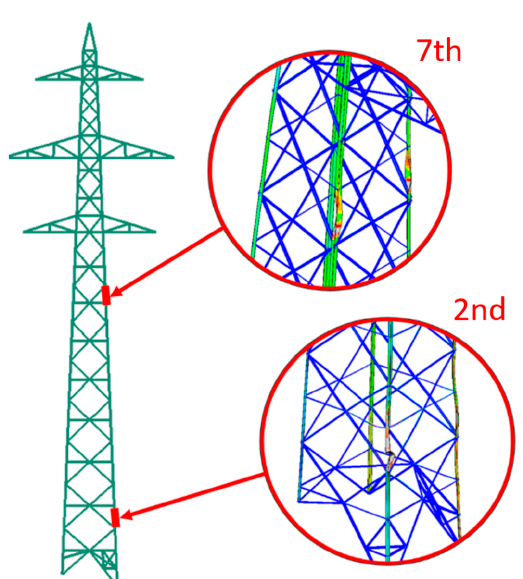
Figure 25. Failure positions at 7th and 2nd level are highlighted.